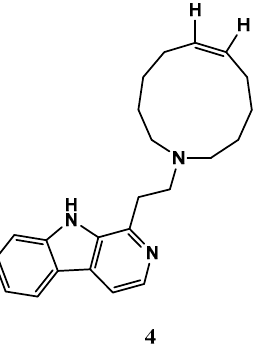
Figure 5. The chemical structure of manzamine C ( 4 ).